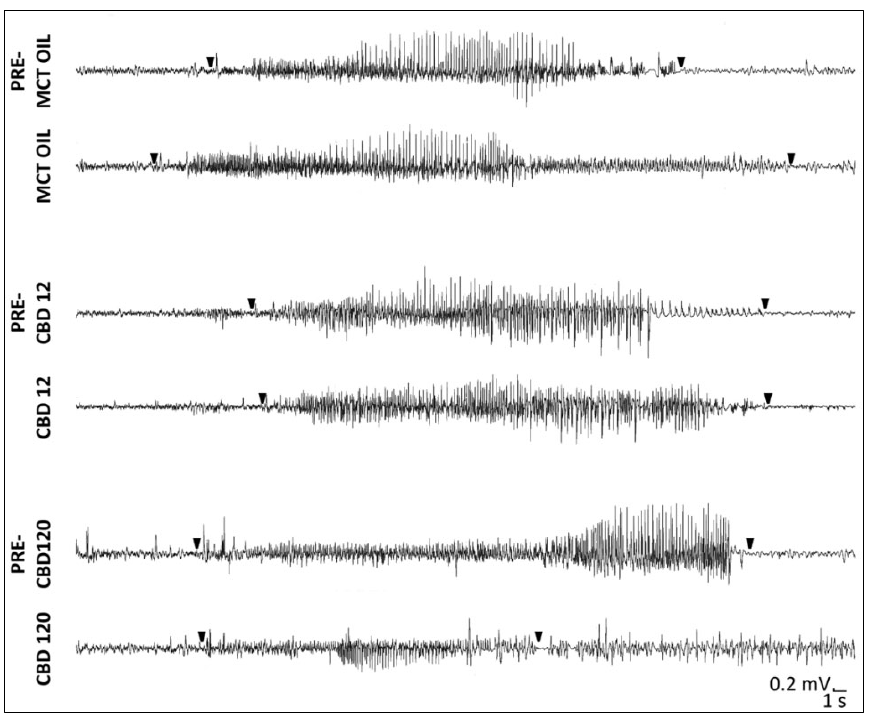
Figure 2. Spontaneous recurrent seizures (SRSs) after induction of status epilepticus in epileptic rats treated with cannabidiol (CBD) at 12 mg/kg, 120 mg/kg, or with medium ‐ chain triglyceride (MCT) oil. SRSs were recorded in rats during the treatment with CBD or MCT oil, but also 3 days before (PRE ‐ MCT OIL, PRE ‐ CBD12, and PRE ‐ CBD120) the treatment. Notably, SRSs during the high concentrations of CBD belong to incomplete responders. Arrowheads represent the onset and termination of SRSs.